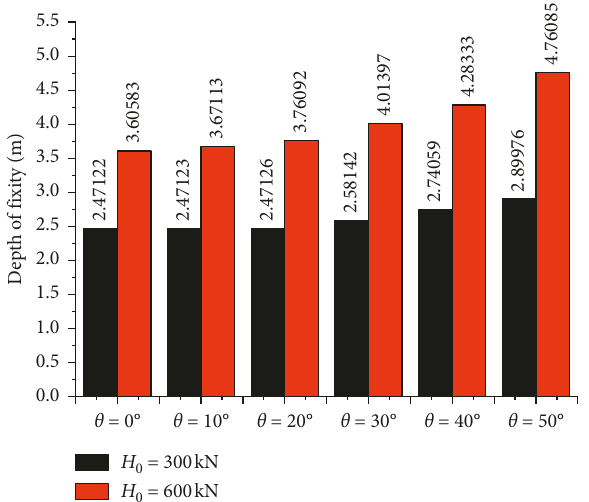
50 ° for different (cid:31)